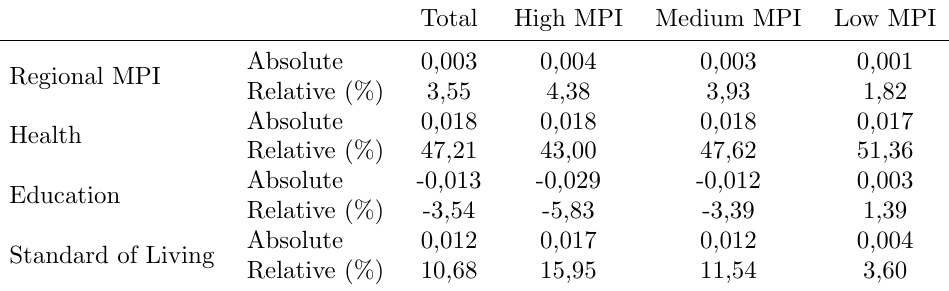
Table 9: Absolute and relative changes 2006/11 of the MPI values within sub-groups and for each dimension